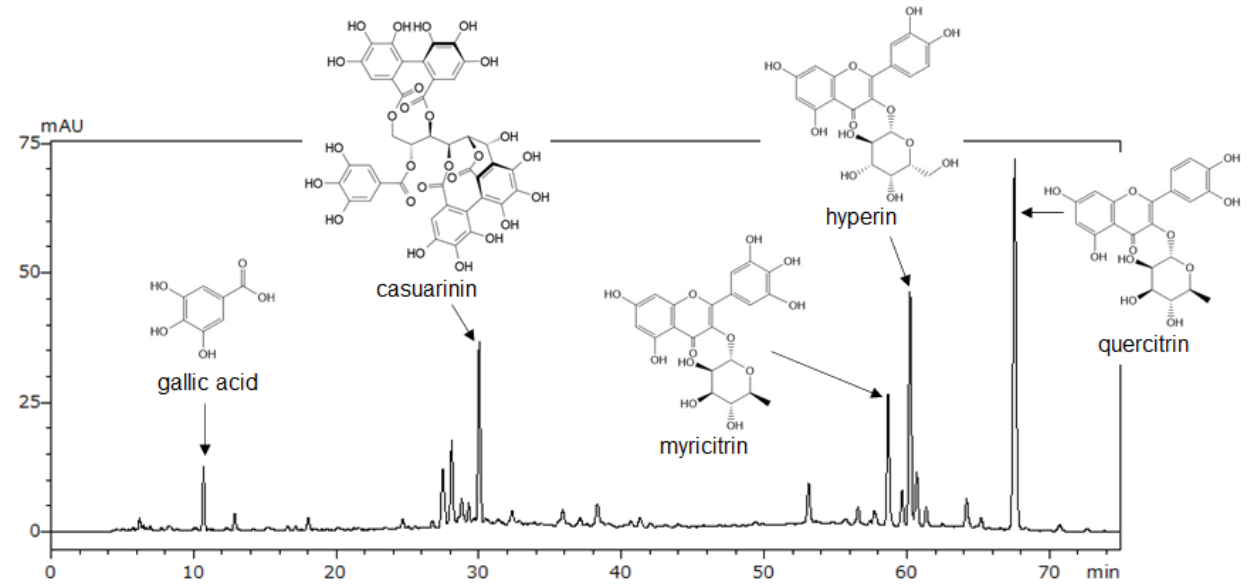
Figure 2. HPLC chromatogram of LM at 270 nm. Gallic acid, myricitrin, hyperin, and quercitrin were identified by comparison with standard compounds in HPLC analysis following LC-MS/MS. Casuarinin was identified by NMR analysis following LC-MS/MS. Table 1. Content of the major compounds in LM. Compound